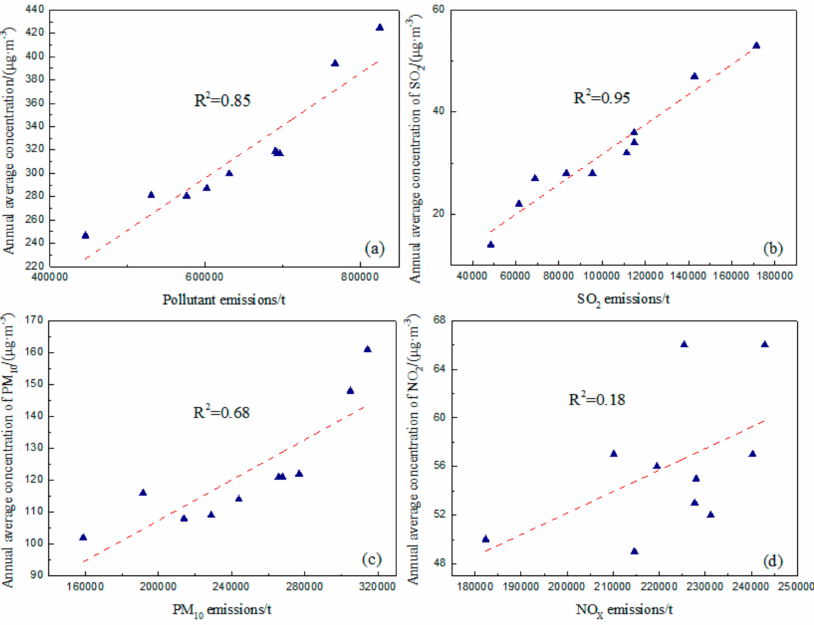
Figure 6. The correlation between pollutant emissions and annual average pollutant